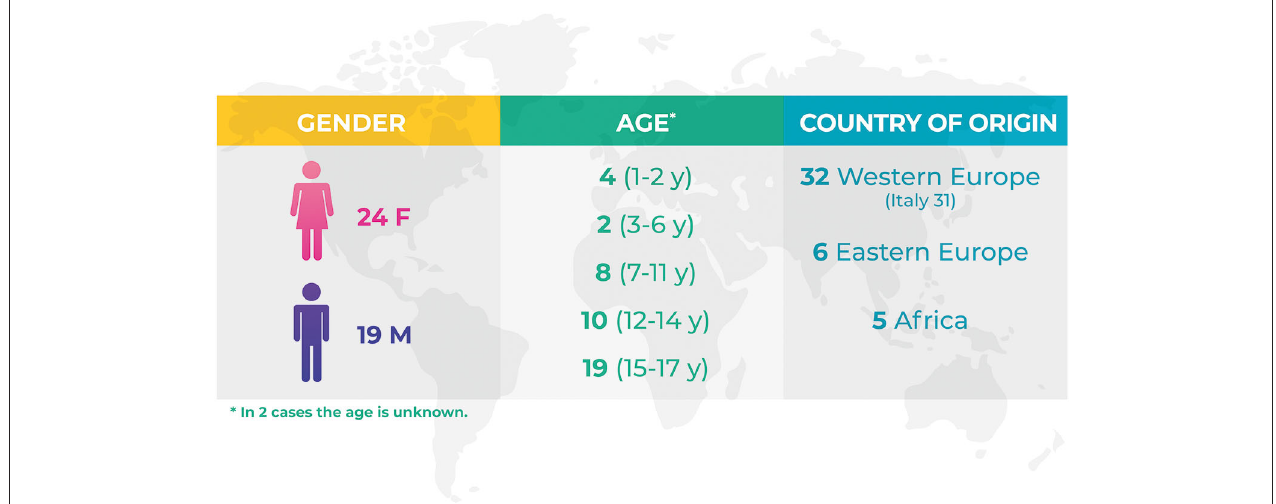
FIGURE 1 | Demographics data of the reported Pink Code events.